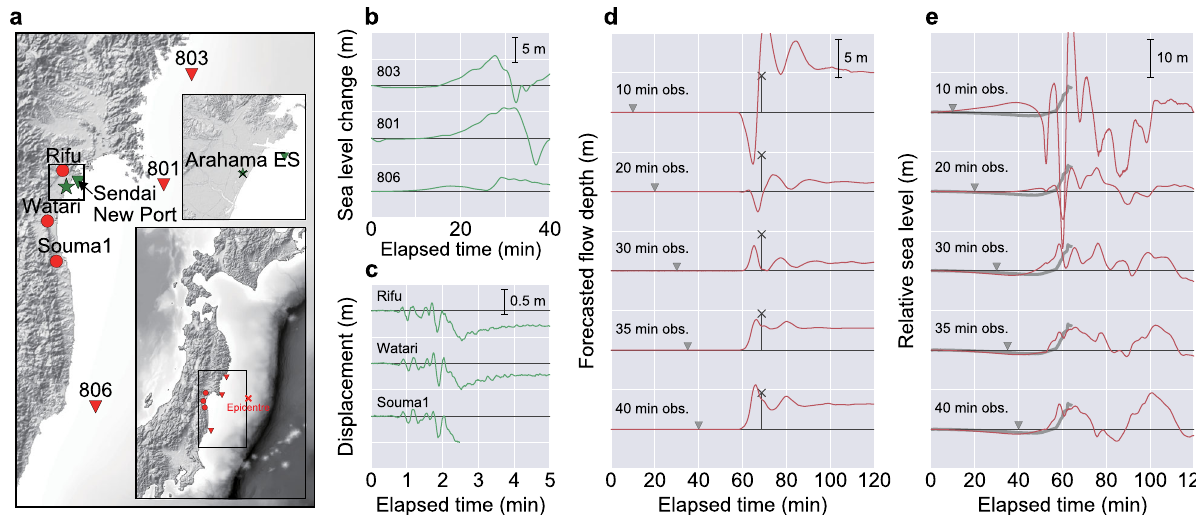
Fig. 6 Observation points and data for the 2011 Tohoku tsunami for the convolutional neural network (CNN) and forecasting results. The elapsed time is from the earthquake occurrence. a Observation points for the CNN and the forecasting site. The red triangles represent the offshore tsunami observation points (803, 801, 806), and the red circles represent onshore geodetic observation points (Rifu, Watari, Souma1). The red cross mark in the small-scale map represents the epicentre of the 2011 earthquake. The forecasting site is shown in the large-scale map as the green star. Arahama ES (the black cross mark) where tsunami inundation traces for validation are available is located close to the forecasting site. b Tsunami waveforms at 803, 801 and 806 observed during the 2011 event 31 . c Geodetic observations at Rifu, Watari and Souma1 observed during the 2011 event. d Results of tsunami inundation forecasting with different observation periods. Grey triangles represent the observation interval used for forecast. Red waveforms are the CNN forecasting results. The height and position of the black cross mark represents the surveyed tsunami inundation trace at Arahama ES. e Results of offshore tsunami waveform forecasting at the Sendai New Port with different observation periods. Grey triangles represent the observation interval used for forecast. Red waveforms are CNN forecasting results. Grey lines are observed waveforms at the Sendai New Port during the 2011 event. Full observation was not available because the gauge was destroyed by the